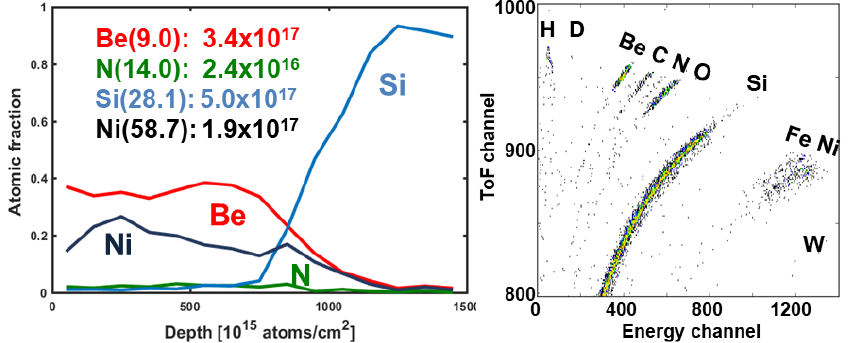
Figure 7. ToF-HIERDA depth profile and spectrum of co-deposit on the silicon plate of the dust monitor in JET-ILW. monitor in